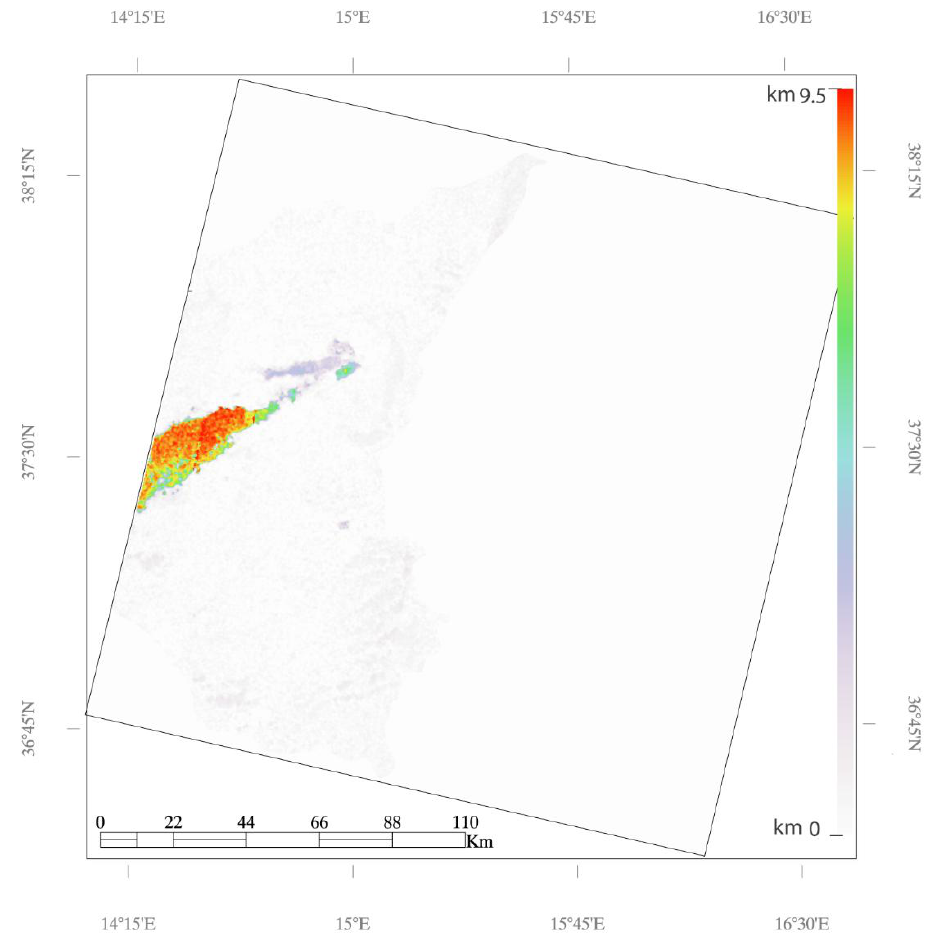
Figure 4. The volcanic cloud elevation (km), extracted from Landsat 8 orthorectified image. 182